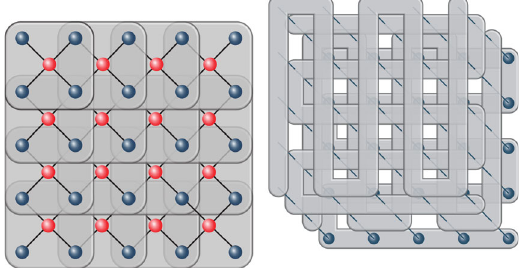
FIG. 3. (a) A locally connected RBM is an EPS where each plaquette encodes the local connections to a hidden unit. (b) Once expressed as a SBS, a fully connected RBM can be represented by many strings on top of each other. Enlarging the RBM by using noncommuting matrices to nonlocal SBS induces a geometry in each